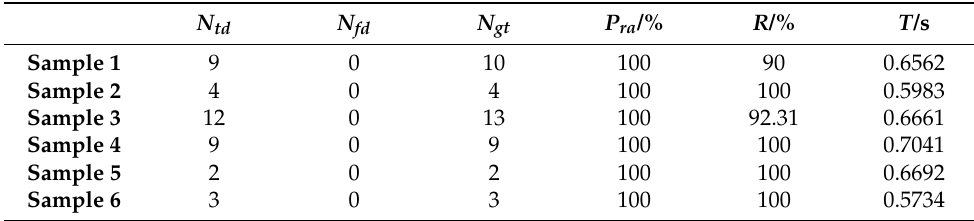
Figure 18. Detection results of the Faster R-CNN: ( a ) sample 1; ( b ) sample 2; ( c ) sample 3; ( d ) sample 4; ( e ) sample 5; and ( f ) sample 6. Table 3. Statistics of the Faster R-CNN detection